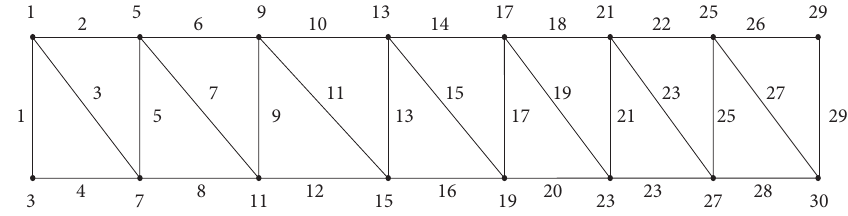
Figure 8: A classical mean labeling of TL